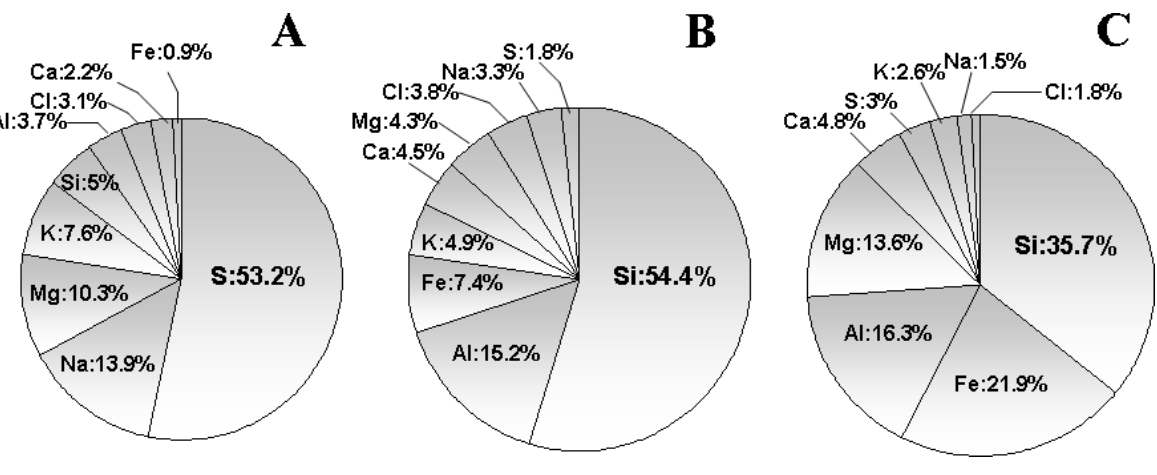
Figure 3. The mass concentration (%) of each component for particles averaged over 100 particles derived from an energy-dispersive X-ray analyzer (EDX).